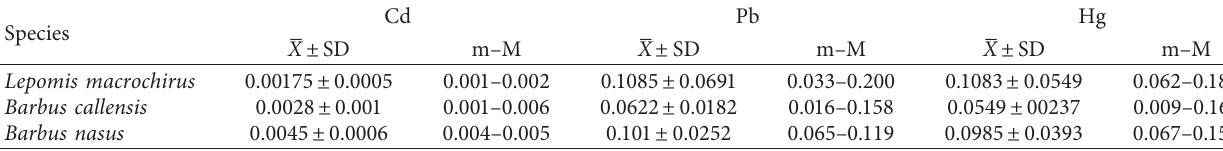
Table 4: Contents of trace metals dosed in the muscles of studied fish species (mg/kg of wet weight).